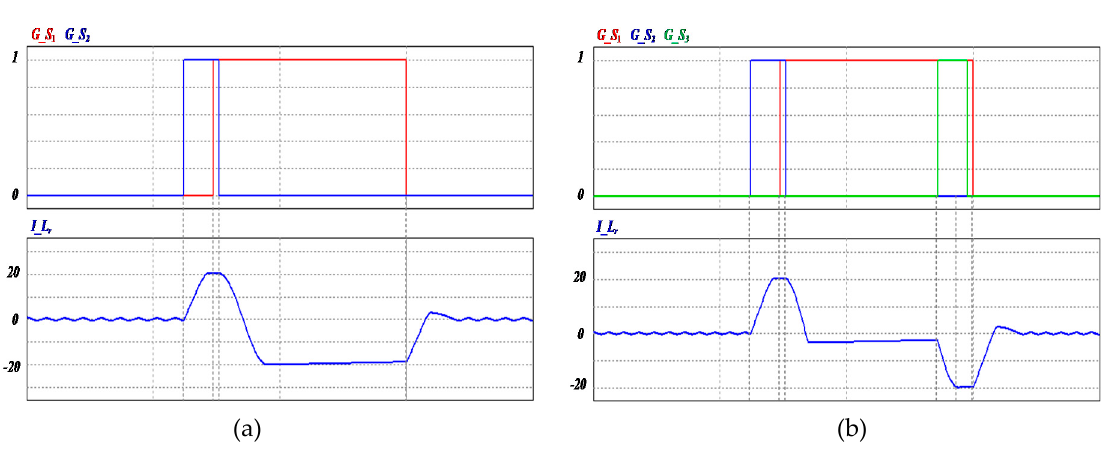
(b) Figure 16. ( a ) Waveforms of voltage and current of each switch and ( b ) expansion waveforms. Figure 17. Waveforms of input/output voltage and current. 4. Experimental Results In order to prove the theoretical analysis, experiments were conducted on the proposed ZVT boost converter in Figure 18. It consists of a boost converter, a controller, and a gate driver. The controller used in this experiment was the DSP TMS320F28335 from TI. The experiment was conducted with the 4 kW, 30 kHz converter, which steps up the voltage from 200 V to 380 V.